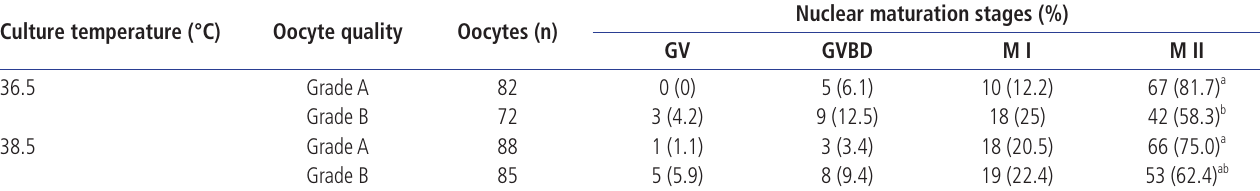
Table 2. Nuclear maturation status of bovine oocytes, matured in vitro either at 36.5°C or 38.5°C maturation temperatures per groups for 5 replicates Culture temperature (°C) Oocyte quality